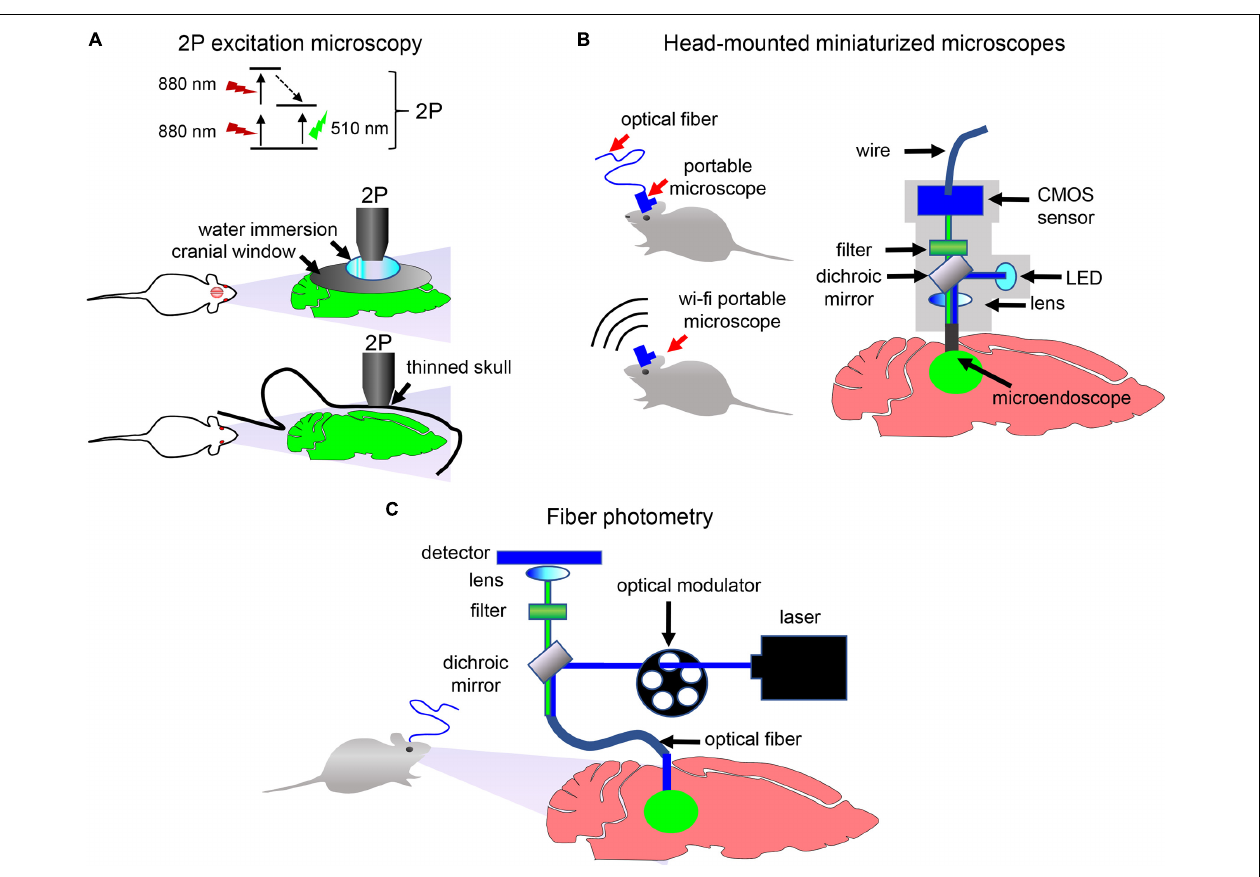
FIGURE 5 | Detection and imaging of neuronal activity in vivo . (A) 2P excitation microscopy of immobilized animals. Principle of the 2P excitation is depicted (top). Non-invasive 2P imaging of the brain in immobilized animals through the cranial window (middle) and through the thinned skull (bottom) is shown. (B) Schematics of the portable single-photon microscope for imaging of neurotransmission in freely moving animals. Imaging data can be transferred to the detection device using either optical fiber or wirelessly. (C) Schematics of the fiber photometry setup for detection in freely moving animals. Optical fiber is implanted in the animal brain. Optical modulator determines excitation light frequency. Fluorescent signal from biosensor is collected with the same frequency using photodetector and normalized to a signal at times when excitation light is turned off (Resendez and Stuber,